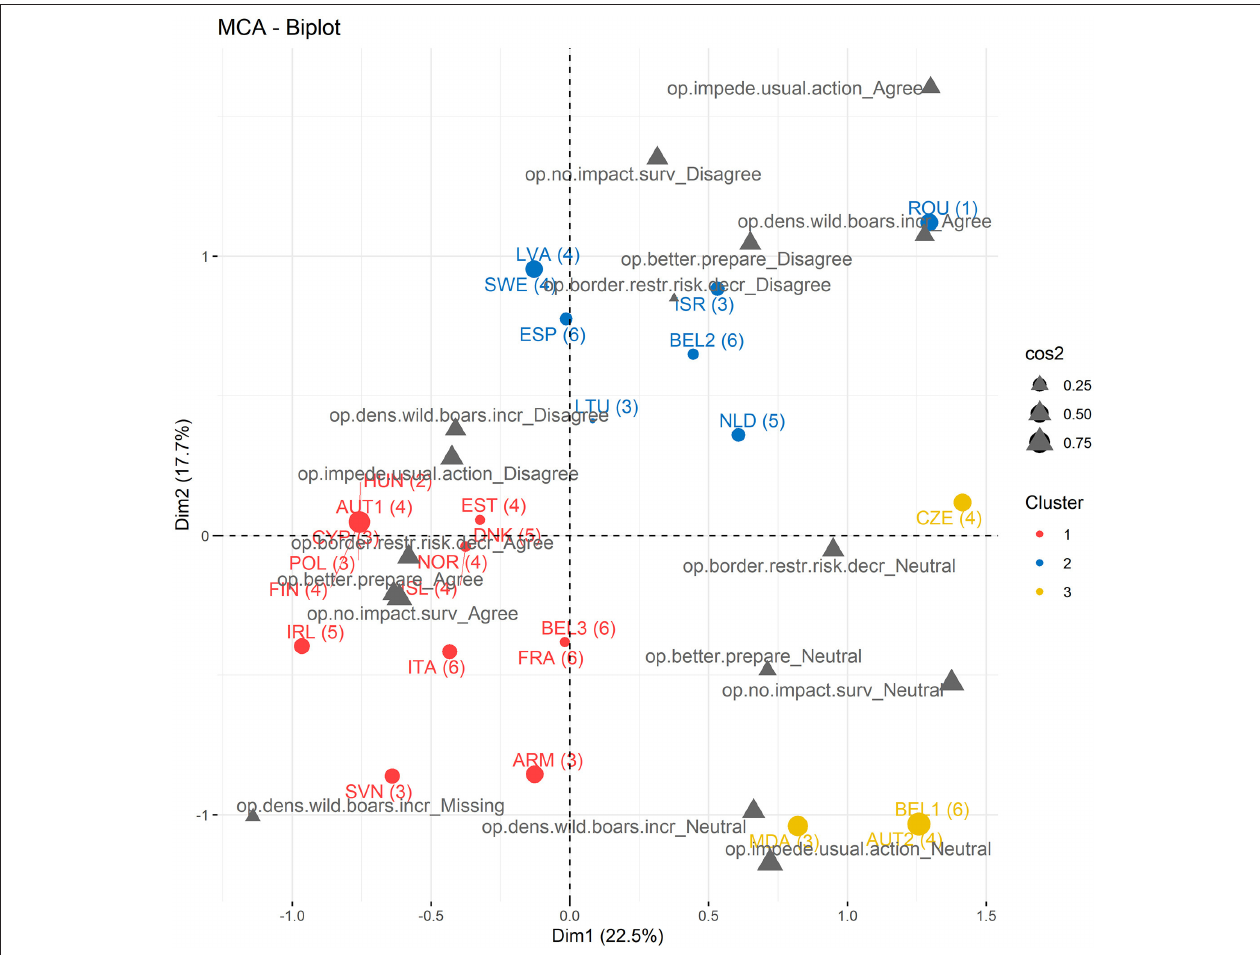
FIGURE 7 | Biplot of the first two axes of the multiple correspondence analysis (MCA) showing the clustering of the 27 survey participants based on their answers to the section five of the questionnaire (Likert-scale response categories). Survey participants are colored according to their cluster. Numbers in brackets correspond to the cluster numbers grouping countries based on sanitary and economic variables (PCA-HCPC, Figure 2 ). Dot size corresponds to cos2 value. ARM, Armenia; AUT, Austria; BEL, Belgium; CYP, Cyprus; CZE, Czech Republic; DNK, Denmark; ESP, Spain; EST, Estonia; FIN, Finland; FRA, France; ISL, Iceland; ISR, Israel; ITA, Italy HUN, Hungary; IRL, Ireland; LVA, Latvia; LTU, Lithuania; MDA, Moldova; NLD, Netherlands; NOR, Norway; POL, Poland; ROU, Romania; SVN, Slovenia; SWE, Sweden (number attached to some country ISO corresponds to respondent number when more than one respondent from a country answered to the